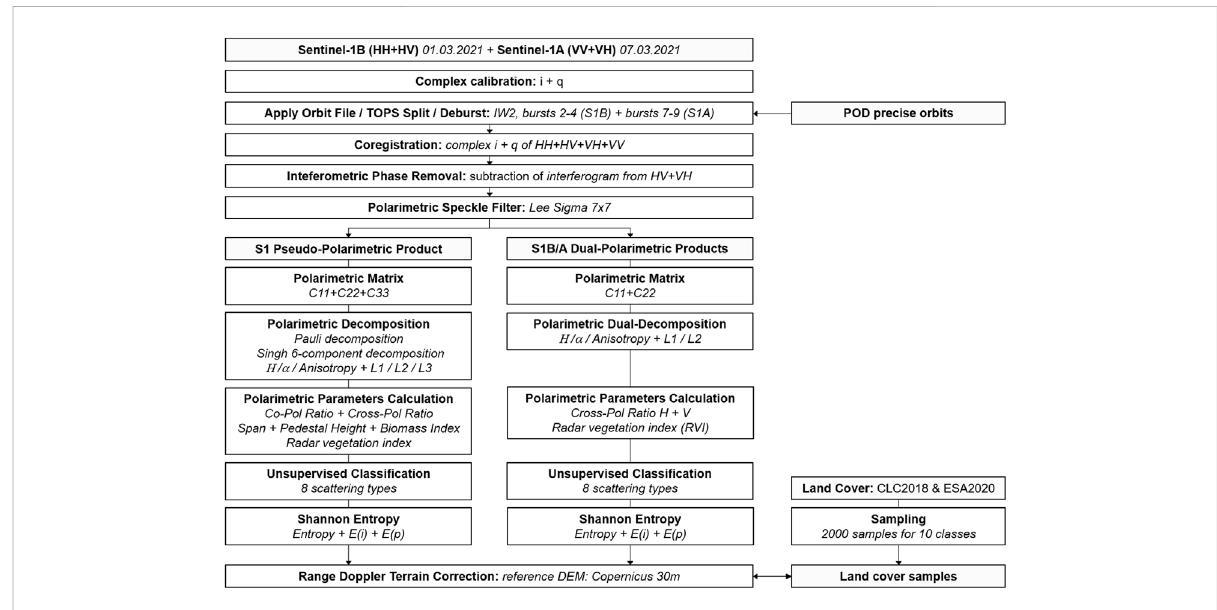
FIGURE 2 Processing work fl ow of the Sentinel-1 data in this